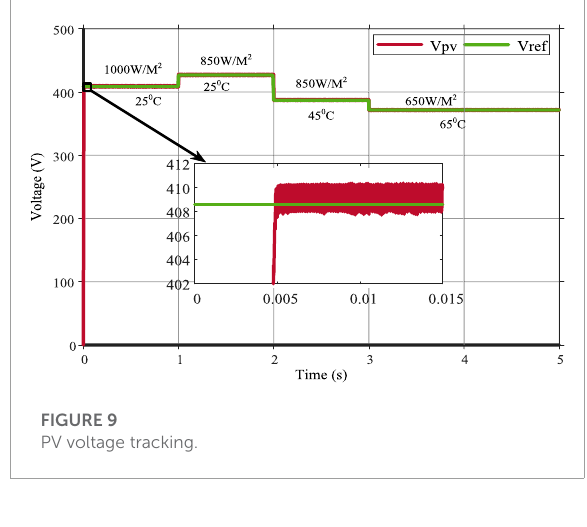
FIGURE 9 PV voltage tracking.